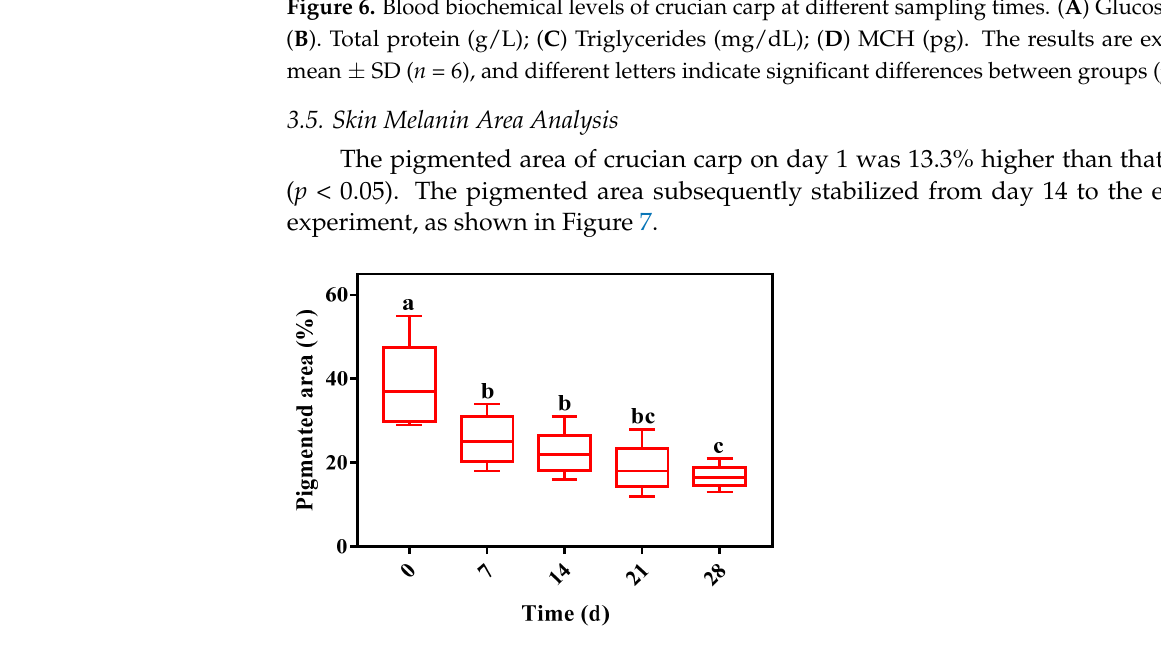
Figure 7. Skin pigmented area (%) of crucian carp at different sampling times. Results are expressed as mean ± SD ( n = 6), and different letters indicate significant differences between groups ( p < 0.05).